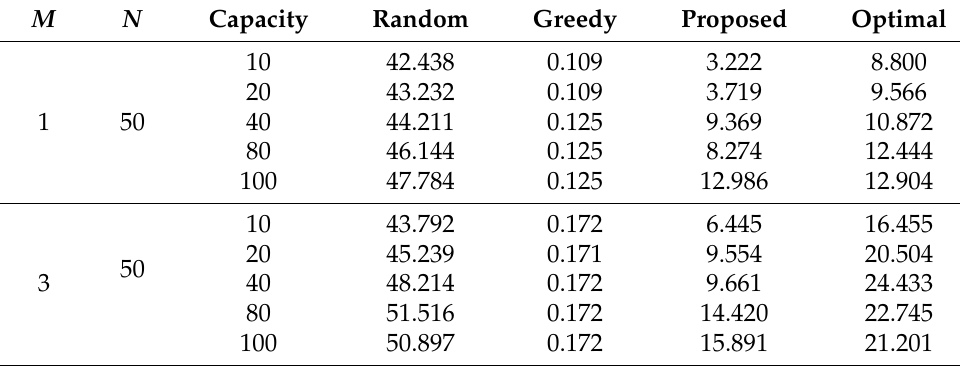
Table 15. Computation time (seconds) in